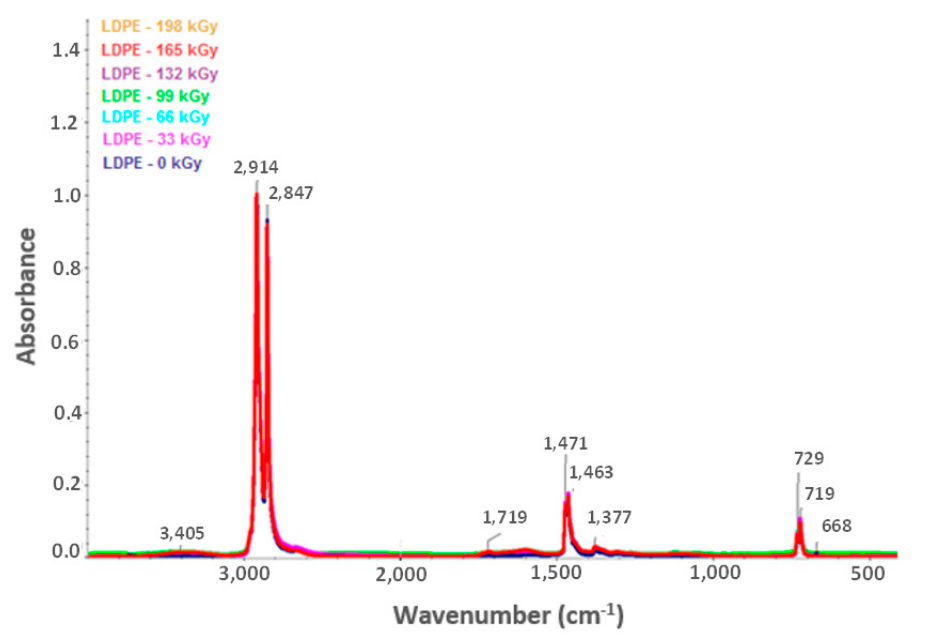
Figure 12. Infrared spectra of irradiated LDPE [29].